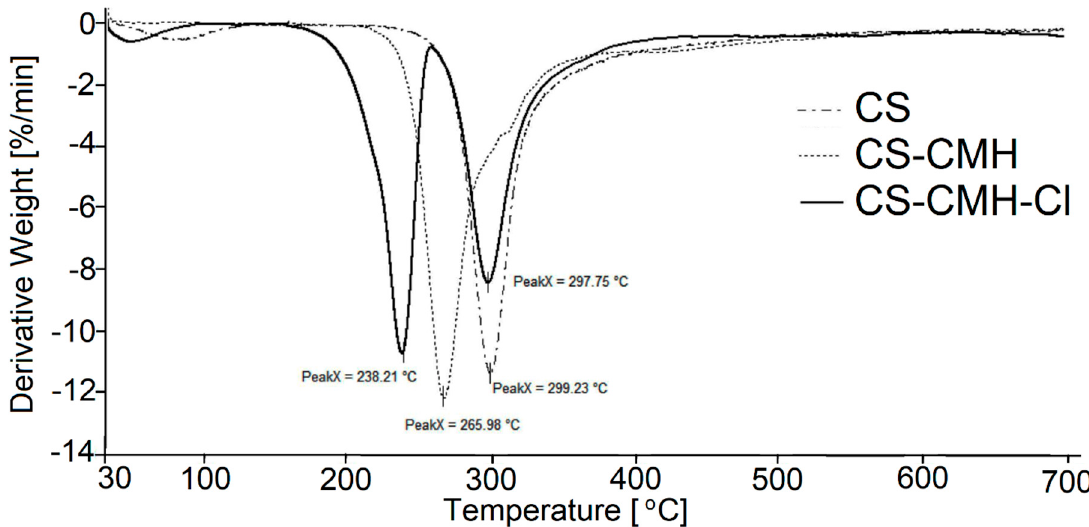
Figure 6. DTG curves of the obtained chitosan films. Table 2. Thermal parameters of the tested materials.